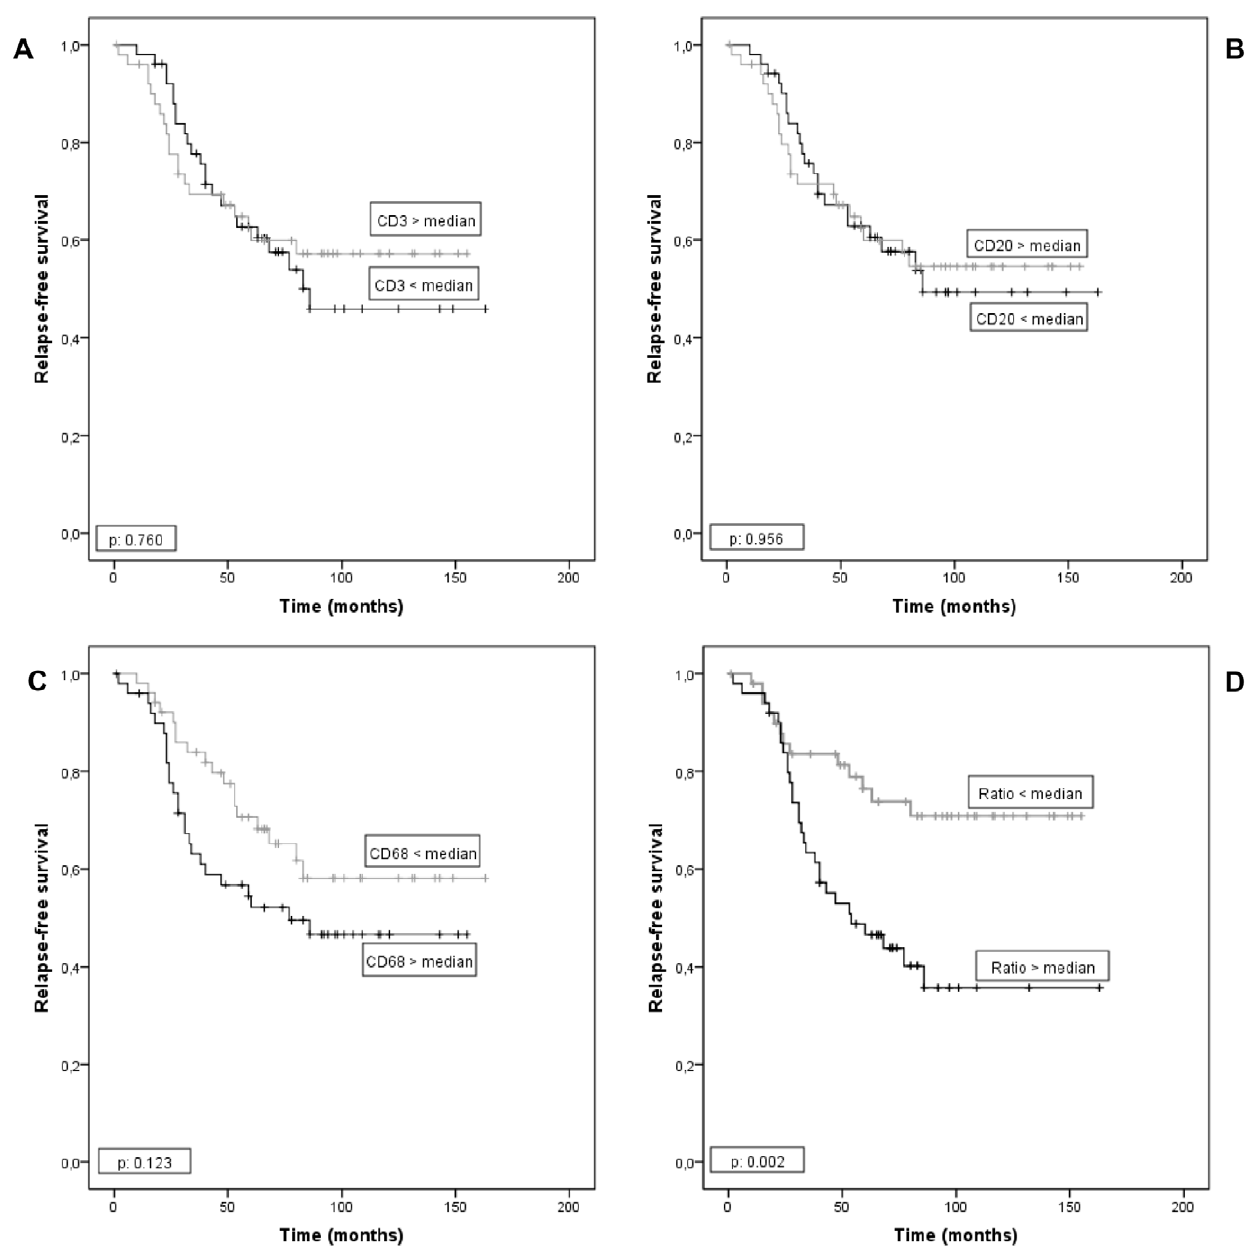
Figure 4. Probability of relapse-free survival as a function of CD markers count for 102 patients with invasive ductal carcinoma. CD3 count (A), CD20 count (B), CD68 count (C) and CD68/(CD3 + CD20) ratio (D).